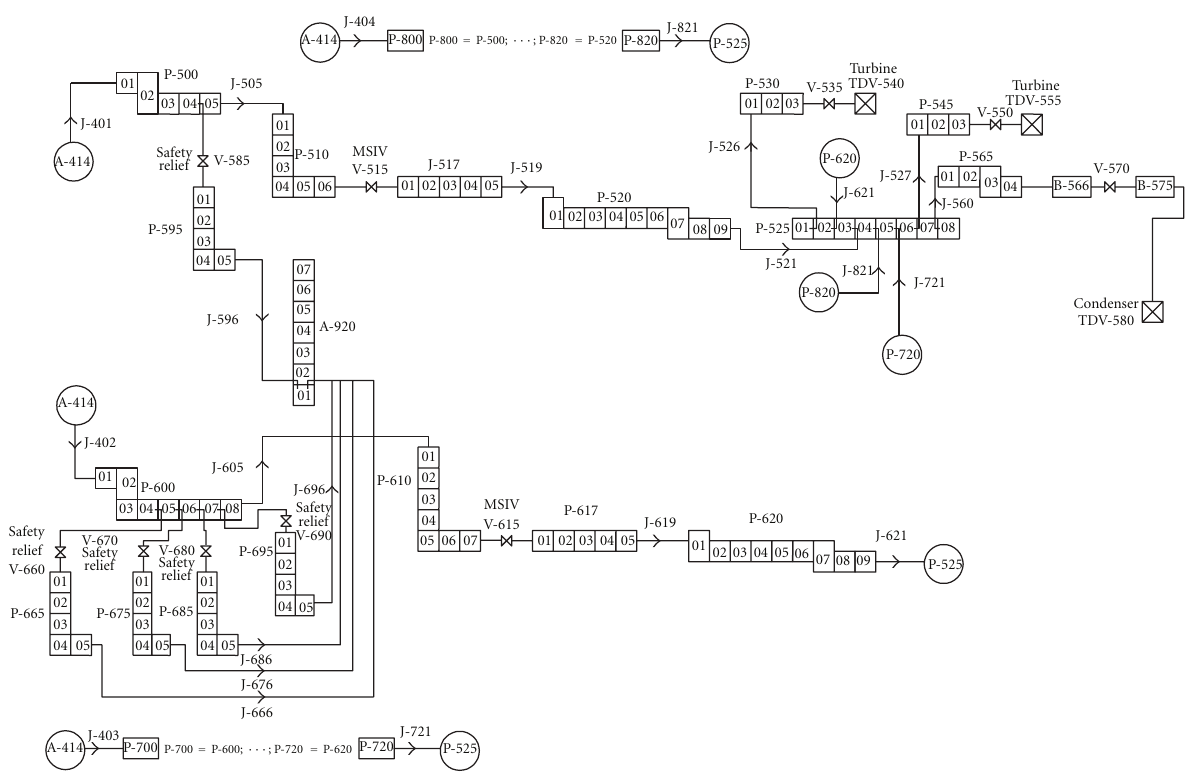
Figure 8: Laguna Verde: main steam line detailed